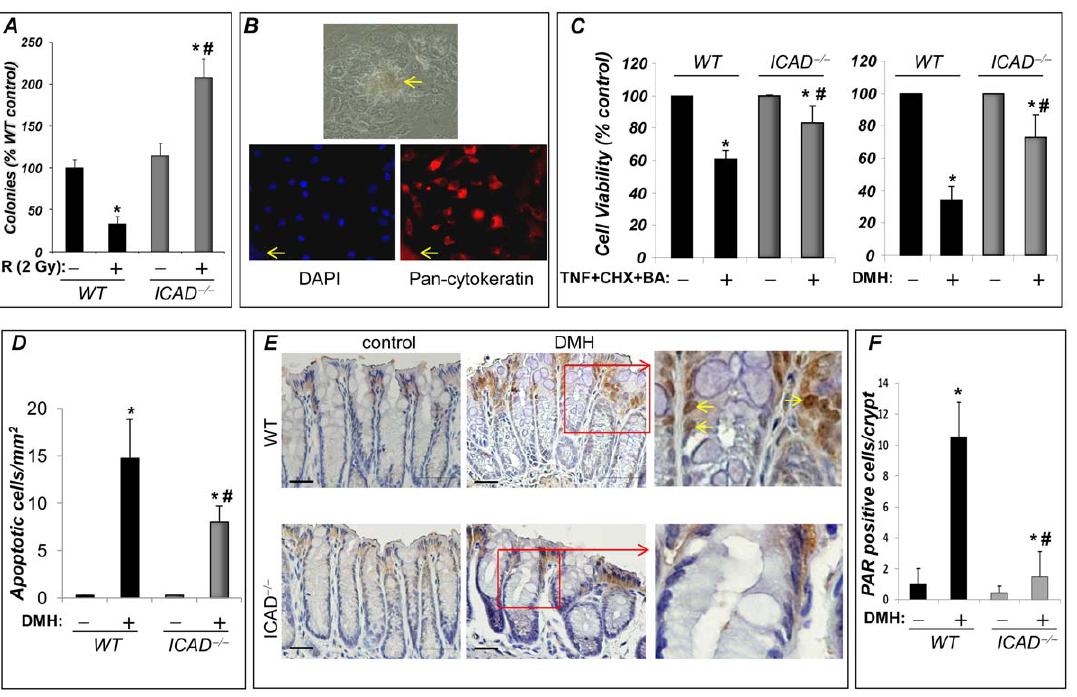
Figure 2. Effect of ICAD deficiency on colony formation in soft agar by fibroblasts exposed to IR and on TNF + CHX + BA or DMH- induced death in CECs. ( A ) ICAD 2 / 2 and WT mouse fibroblasts were either exposed to IR (2 Gy) or sham-irradiated, after which they were cultured in soft agar with complete medium for 3 weeks. Colonies were then counted with an automated counter. Data are expressed as a percentage of the value for sham-irradiated WT cells and are means 6 SD of triplicates from a representative experiment. *, difference from sham-irradiated WT cells, p , 0.05; # , difference from WT cells exposed to IR (2 Gy), p , 0.05. ( B ) CECs were prepared from WT mice and allowed to propagate for 4 days. Cells were then fixed and subjected to immunofluorescence with antibodies to pan-cytokeratin (red) or staining with DAPI (blue); top panel is an example of CECs visualized by bright field microscopy. Yellow arrows indicate colonic crypts. ( C ) CECs, isolated from WT or ICAD 2 / 2 mice, were treated with 2.5 ng/ml TNF combined with 5 m g/ml cyclohexamide and 3 mM butyric acid (designated as TNF + CHX + BA) or 1 mM DMH. Cells were incubated for 48 h in the absence or presence of TNF + CHX + BA or DMH, after which, after which cell viability was assessed by measurement of calcein-AM fluorescence. Data are expressed as a percentage of the viability of untreated cells and are means 6 S.D. of values from four wells from a representative experiment. *, Difference from respective control, p , 0.05. # , Difference from respective treated cells, p , 0.05. ( D ) Mice received an ip injection of 20 mg/kg DMH or saline (control). Mice were sacrificed after 48 h, and their distal colons were removed and formalin-fixed. Tissue sections were then prepared and subjected to H&E staining or TUNEL staining. Pycnotic/apoptotic cells were determined by nuclear condensation, cellular fragmentation, shrinkage, and/or detachment from mucosa, aided with TUNEL assay. On average, 40 crypts per section were counted. Results are expressed as the number of pycnotic/apoptotic cells per mm 2 . Data are means 6 SD of values from at least six mice per group. *, difference from the respective untreated mice; p , 0.01; # , difference from WT mice exposed to DMH, p , 0.01. ( E ) Mice were treated as in ( D ) except that they were sacrificed after 24 h. Distal colons were removed and formalin-fixed. Tissue sections were then prepared and subjected to IHC with antibodies to poly(ADP-ribose). Red boxes indicate the magnified regions; yellow arrows show poly(ADP-ribose)-immunoreactive nuclei. ( F ) A quantification